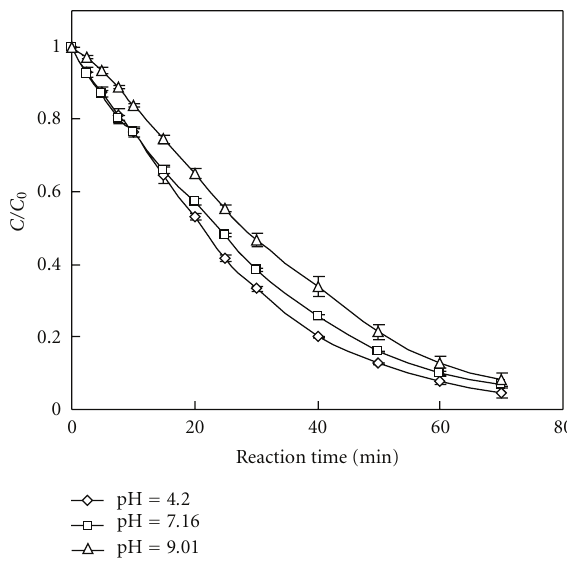
Figure 5: E ff ect of initial pH on the RhB degradation rate during the UV/K 2 S 2 O 8 treatment system. Conditions: [RhB] = 0.02 mM, [K 2 S 2 O 8 ] = 0.4mM, no pH